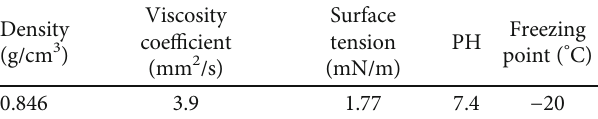
Figure 2: Diesel oil. Table 2: Basic parameters of